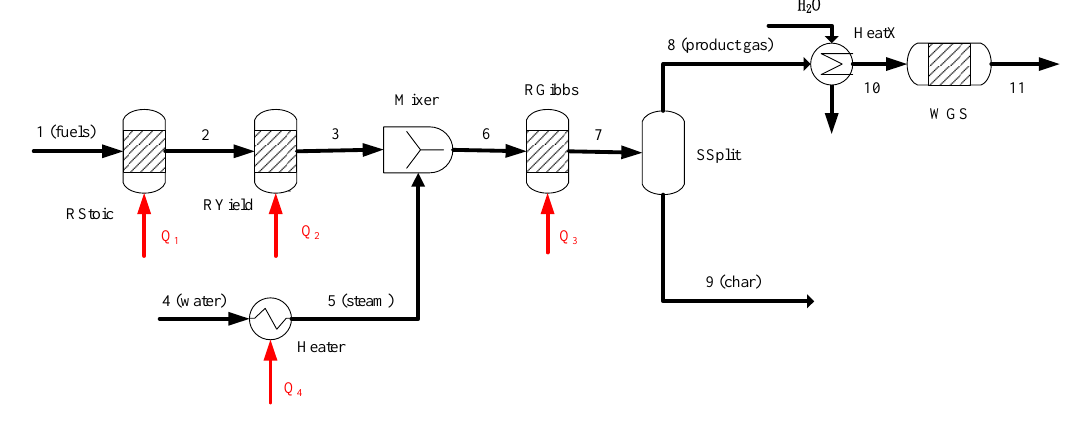
Figure 1. Flow chart of the steam gasification